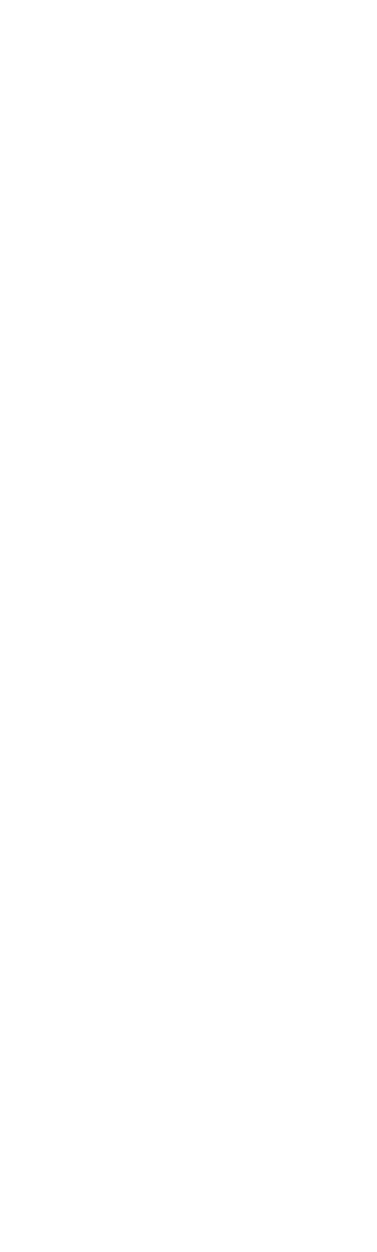
FIGURE 1 Inputs and Outputs of supervised, unsupervised and semi-supervised learning. In supervised learning (A) all data is labeled. Labels are used to train a classi fi er to map learned labels to previously unseen data. Unsupervised learning (B) does not use labels. Data is being clustered into groups based on inherent patterns. Semi-supervised learning (C) uses both labeled and unlabeled data. Labels are used to train a classi fi er which is augmented by unlabeled data of the same distribution to derive additional information in order to boost